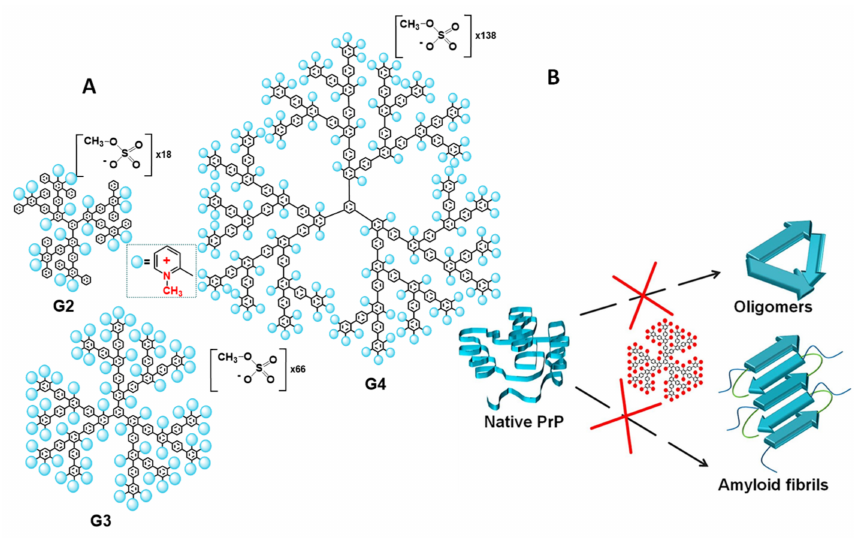
Figure 5. Structures of CPPDs of the second, third and fourth generations ( A ) and schematic repre- sentation of CPPDs influence of amyloidogenic prion protein ( B